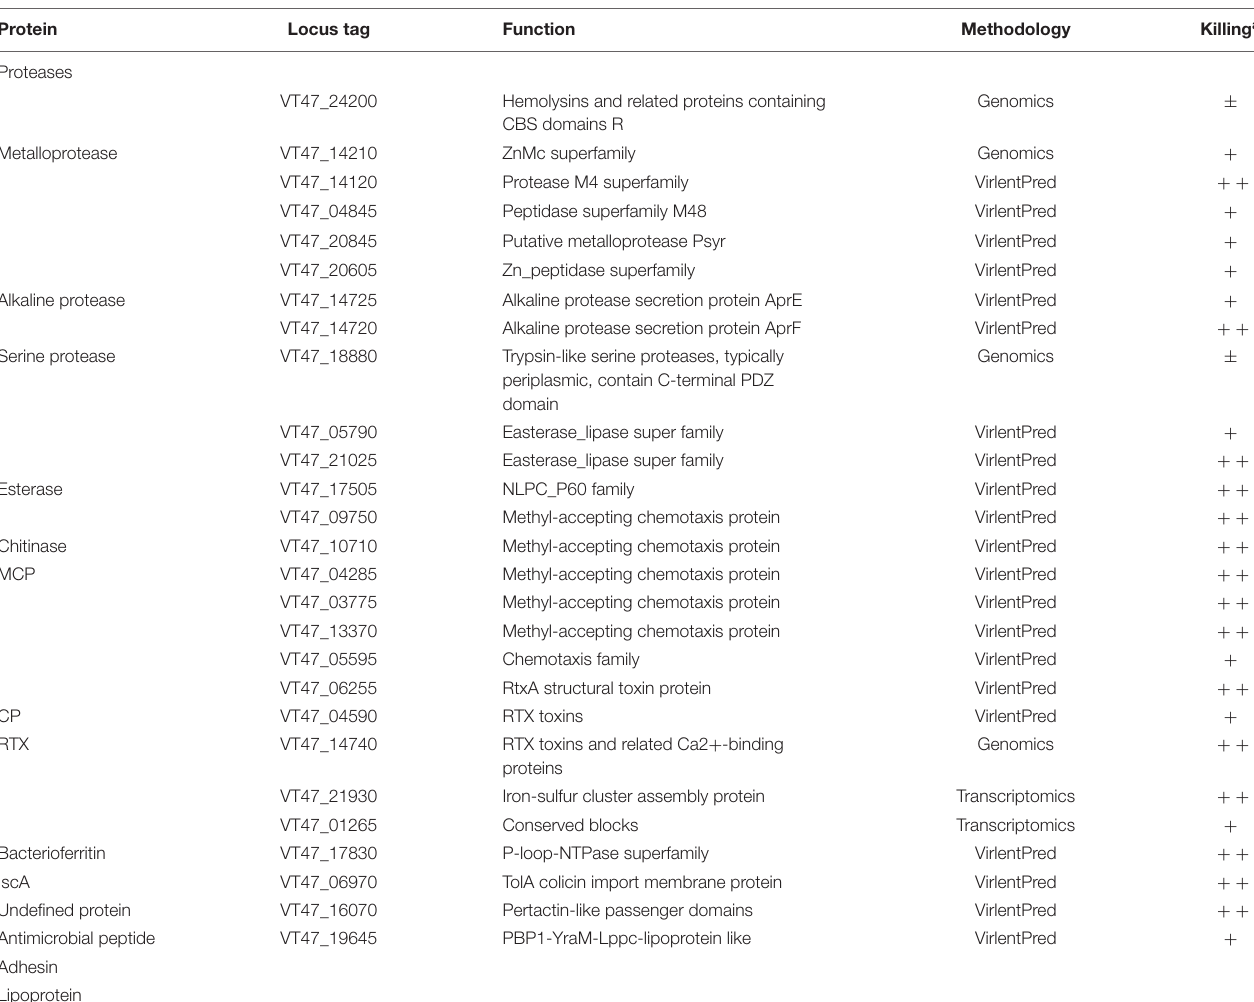
TABLE 6 | Heterologous expression of proteins and nematicidal activity of recombinant E. coli cells.